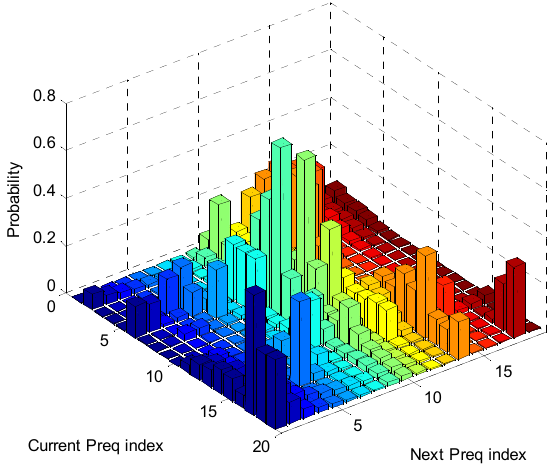
Figure 7. Power request transition probability map at 25